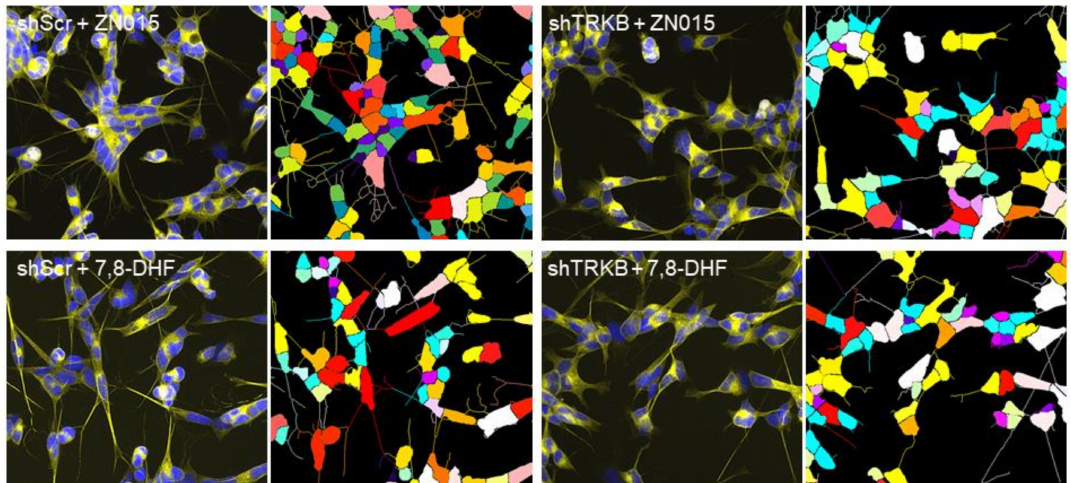
Figure 5. TRKB RNA interference of SH-SY5Y cells expressing A β -GFP. ( A ) Experimental flow chart. On day 1, A β -GFP SH- SY5Y cells were plated with retinoic acid (RA; 10 µ M). On day 2, cells were infected by lentivirus-expressing TRKB-specific or scrambled shRNA. One day post-infection, 5 µ M ZN014, ZN015, or 7,8-DHF (as a positive control) was added to the cells for 8 h, followed by the induction of A β -GFP expression (Dox, 5 µ g/mL) for 6 days. On day 9, the cells were collected for ( B ) TRKB protein (GAPDH as a loading control), ( C ) caspase-1 activity, ( D ) AChE activity, and ( E ) neurite outgrowth analyses ( n = 3). The relative TRKB protein, caspase-1, or AChE activity of uninduced cells (Dox − ) was normalized (100%). Shown on the bottom of ( E ) were images of TUBB3 (yellow)-stained cells, with nuclei counterstained with DAPI (blue), and segmented images with a multicolored mask to assign each outgrowth to a cell body for neurite outgrowth quantification. Processes and branches in scrambled shRNA-infected uninduced cells are marked with red and white arrows, respectively. p -values: comparisons between induced (Dox +) vs. uninduced (Dox − ) cells ( # : p < 0.05, ## : p < 0.01, ### : p < 0.001), between compound-treated vs. untreated cells infected with scrambled shRNA (*: p < 0.05, **: p < 0.01) or between compound-treated vs. untreated cells infected with TRKB shRNA (ˆˆ: p < 0.01, ˆˆˆ: p < 0.001) or between TRKB shRNA-treated vs. scrambled shRNA-treated cells ( & : p < 0.05, && : p < 0.01, &&& : p < 0.001) (one-way ANOVA with a post hoc Tukey test).